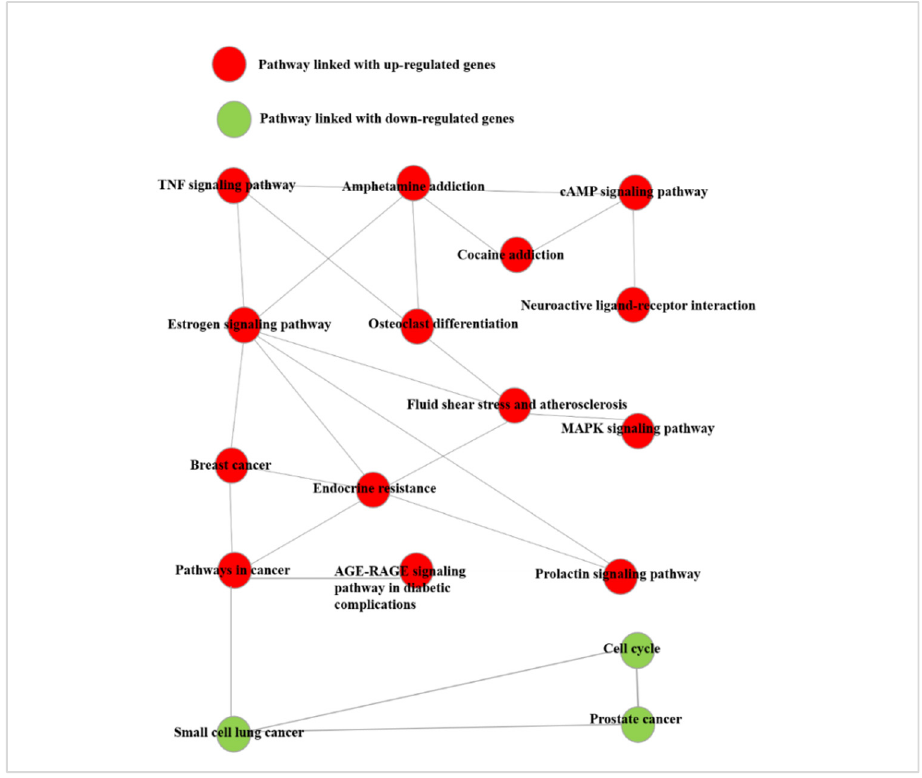
Figure 10. Interactions between the different signalling pathways (using NetworkAnalyst 3.0). Red dots represent upregulated pathways, and green dots represent downregulated pathways.